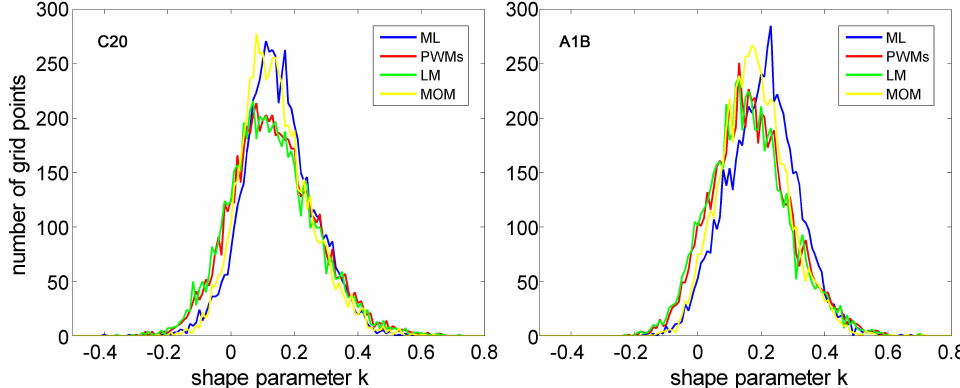
Fig. 3. Shape parameter, k , as a function of different parameter estimators (ML, PWM, LM, MOM) for REMO wind speed